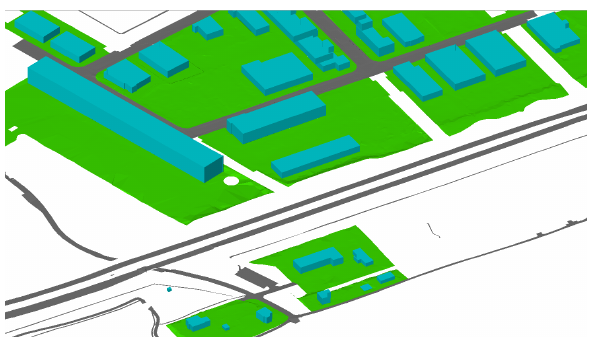
Figure 3: Generated 3D model of the study area